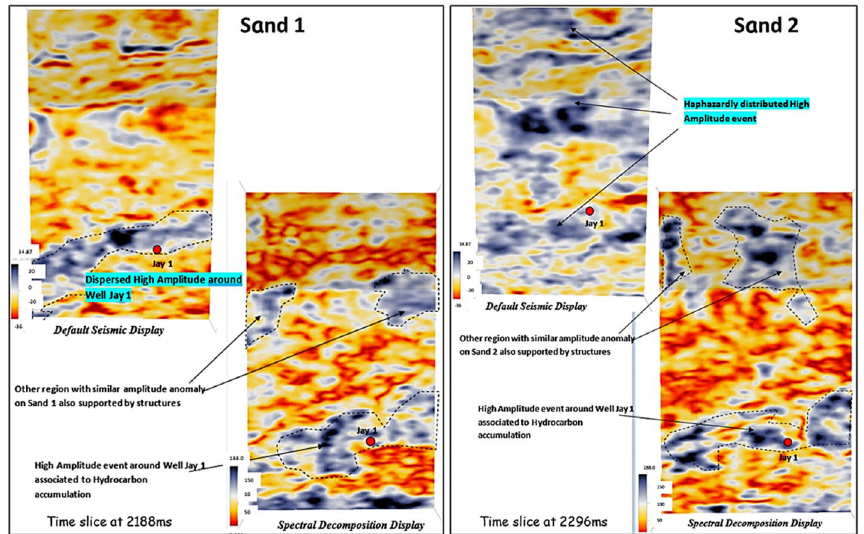
Fig. 18 Default seismic and spectral decomposition attributes of sand 1 and sand